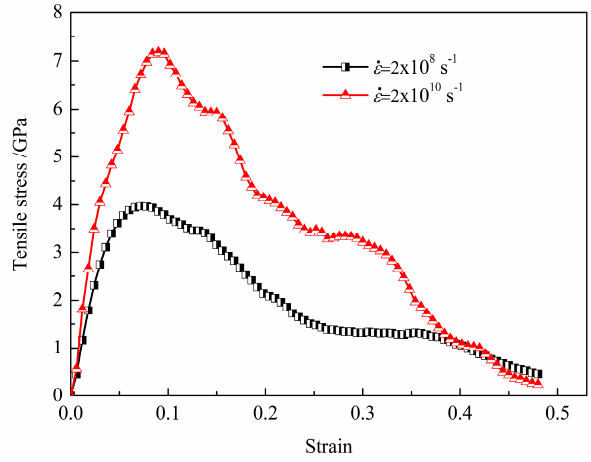
Figure 4. Tensile stress-strain curves for the polycrystal nickel at different strain rates.